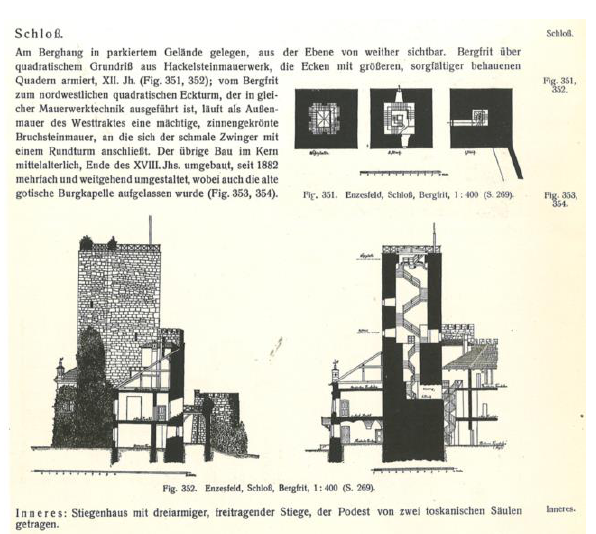
Figure 7. Example from an Austrian Art Topography Volume from the year 1924: Combination of descriptive text and technical drawings in scale